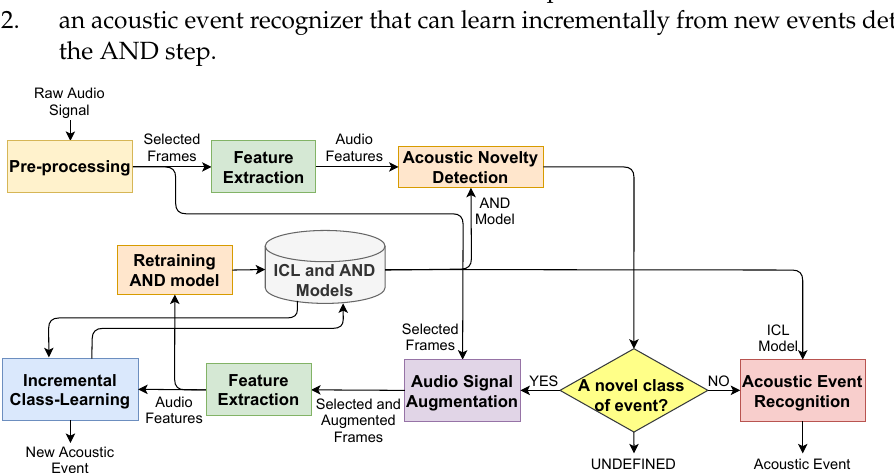
Figure 1. The block diagram of the proposed approach for incremental class-learning with novelty